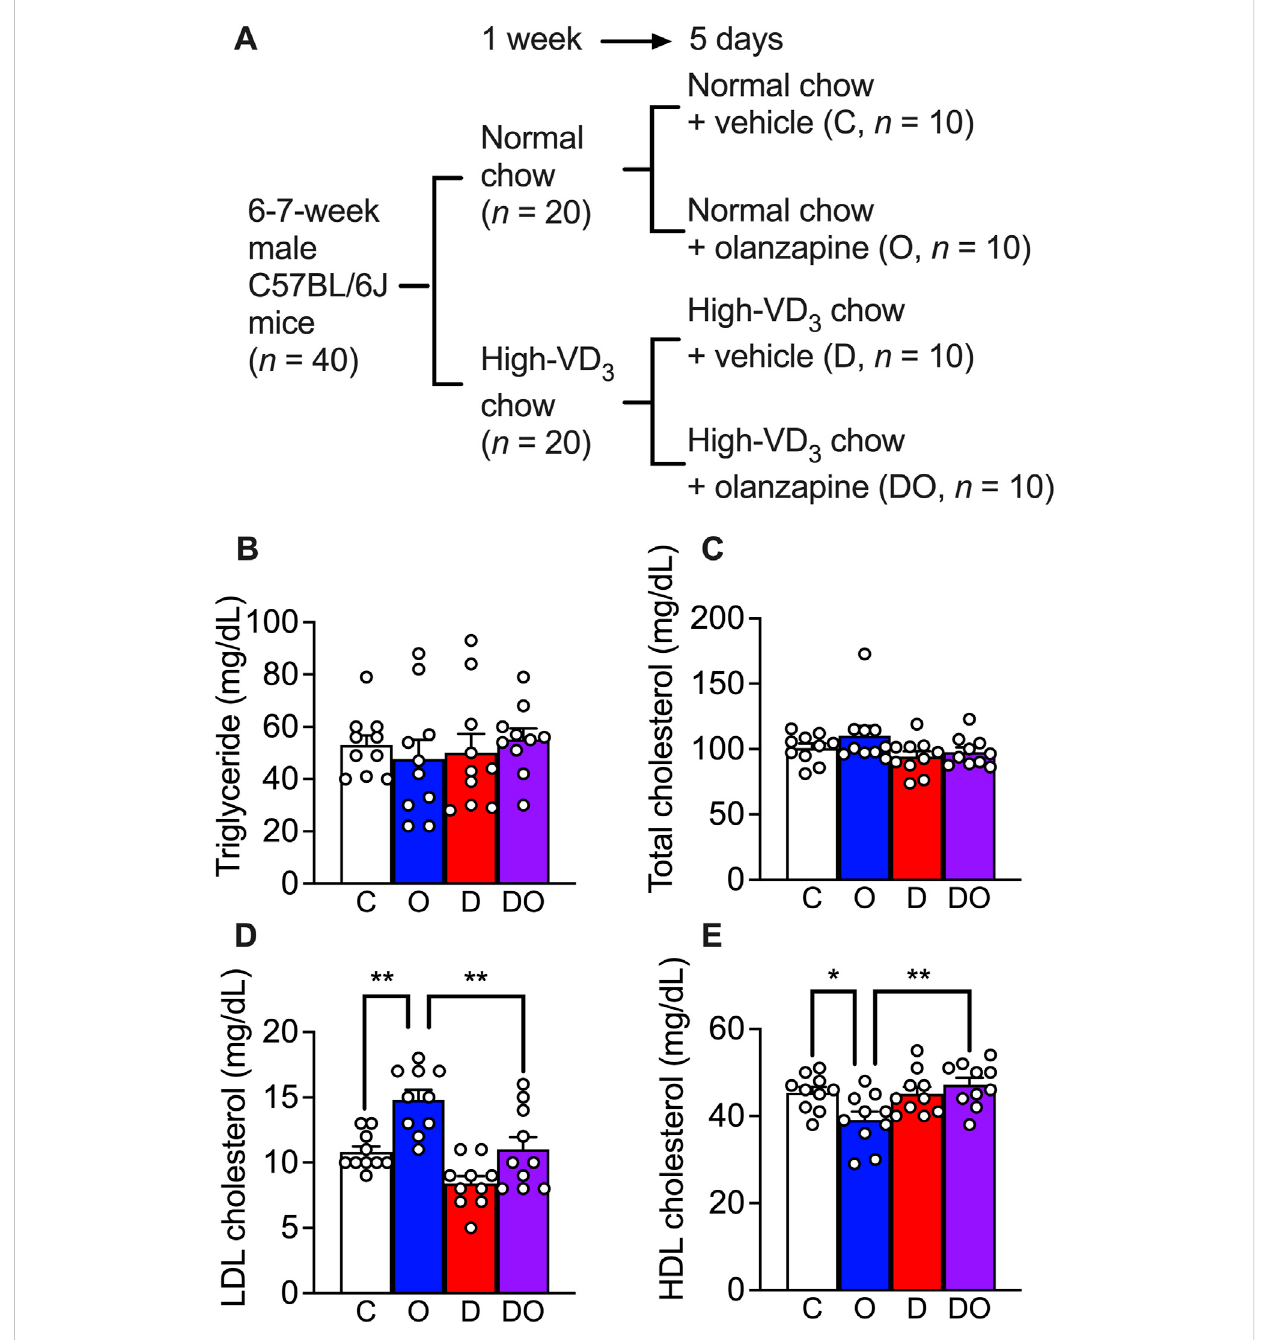
FIGURE 4 Olanzapine treatment caused dyslipidemia in a rodent model while vitamin D 3 supplements attenuated the worsening of the condition. (A) C57BL/ 6Jmicewerefedfor1 weekwiththemedium-fatdiet(containing1.37IUofcholecalciferol/gofchow)orcholecalciferol-supplementedmedium-fatdiet (containing200IUofcholecalciferol/gofchow).Eachgroupofmiceweredividedintotwogroupsandorallygiven10 mg/kg/dayofolanzapineorvehicle for 5 days; resulting 4 groups of mice (each n = 10) received normal chow and vehicle as control (C) , normal chow and olanzapine (O), vitamin D 3 - supplemented chow and vehicle (D) , and vitamin D 3 -supplemented chow and olanzapine (DO). Blood samples were collected from these mice 1 day after thelast dose of olanzapinewithout fasting. (B) the triglycerides, (C) total cholesterol levels, (D) LDL cholesterol levels, and (E) HDL cholesterol levels were measured. Data are shown as means ± SEM. The multiple comparisons of olanzapine and cholecalciferol in fl uences were compared by two-way analysis of variance (ANOVA) with post hoc Tukey ’ s multiple comparison test. * p < 0.05, ** p <